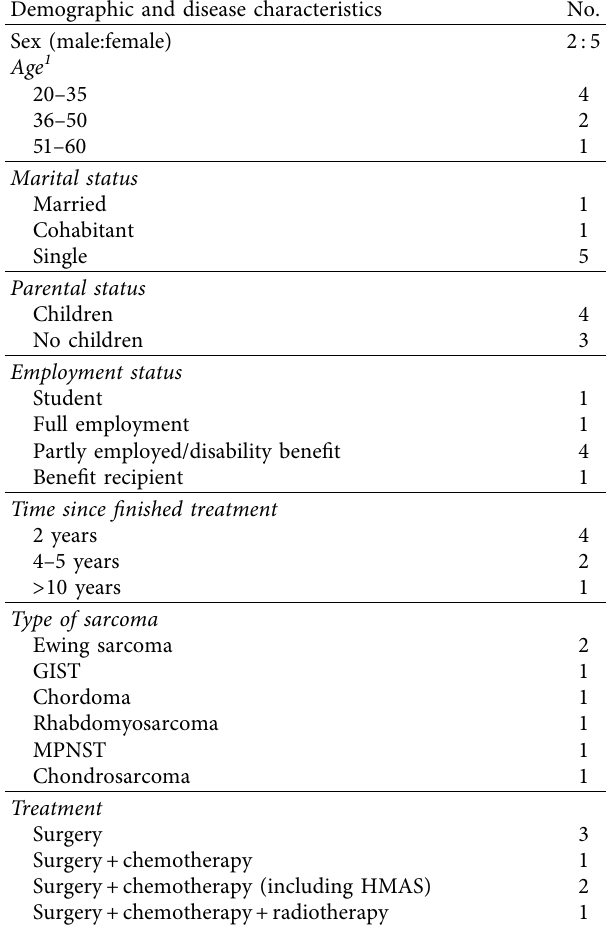
Table 2: Self-reported challenging late effects and improvements described by the mentees ( N � 7) in the applications and/or during the interview.